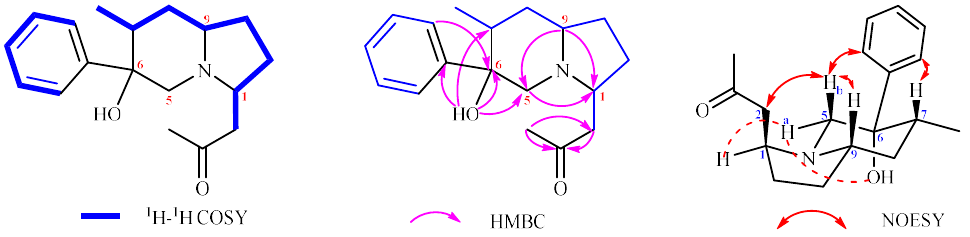
Figure 3. 1 H- 1 H COSY, HMBC, and NOESY correlations of 1 .